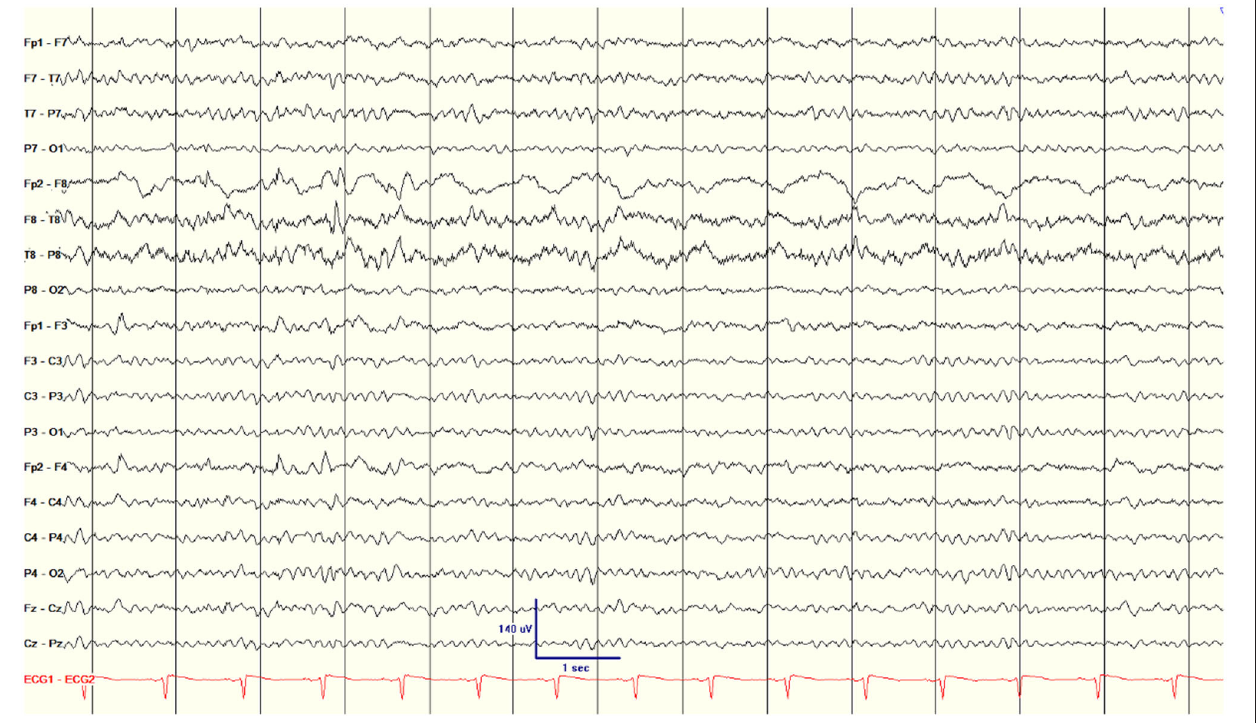
underwent right hippocampal SLAH and had a class IV outcome despite two SLAH on the right side. None of the six patients with either non-lateralizing or contra-lateralizing seizure onset were seizure-free (100% recurrence) compared to 11 of 24 (46%) seizure-recurrence in patients who had only unilateral seizure onset. The average time from surgery to first seizure was